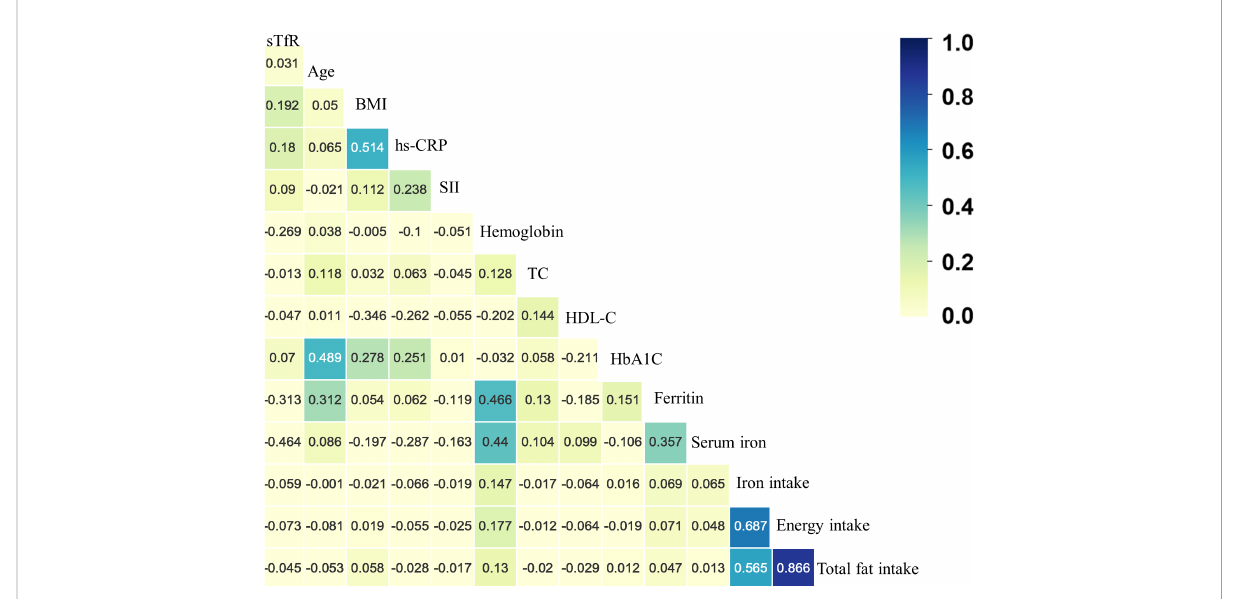
FIGURE 2 The heatmap of the correlation between covariates and serum soluble transferrin receptor (sTfR) using the Spearman correlation analysis among total participants. BMI, body mass index; hs-CRP, hypersensitive C-reaction protein; SII, systemic immune-in fl ammation index; TC, total cholesterol; HDL-C, high-density lipoprotein cholesterol; HbA1c, glycated